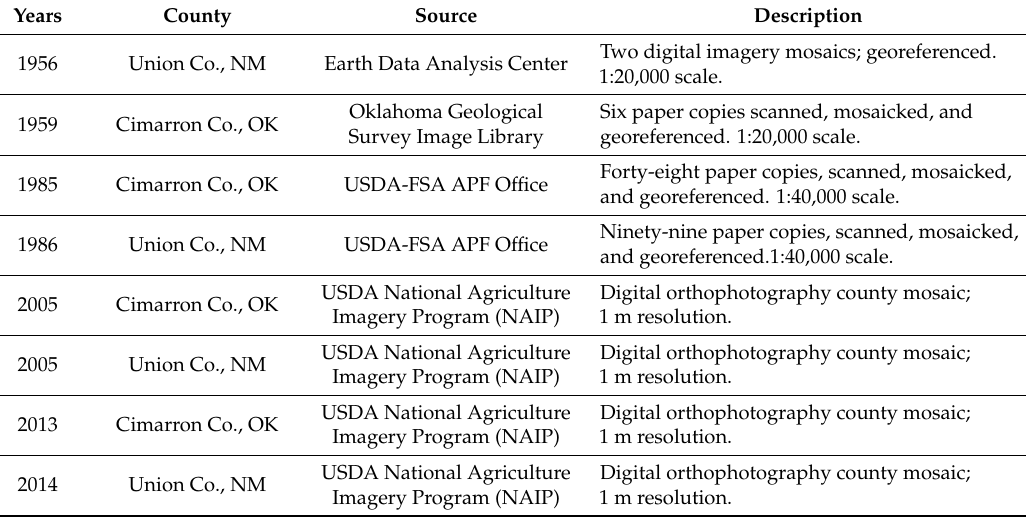
Table 1. Aerial photography dataset: years, sources, and general